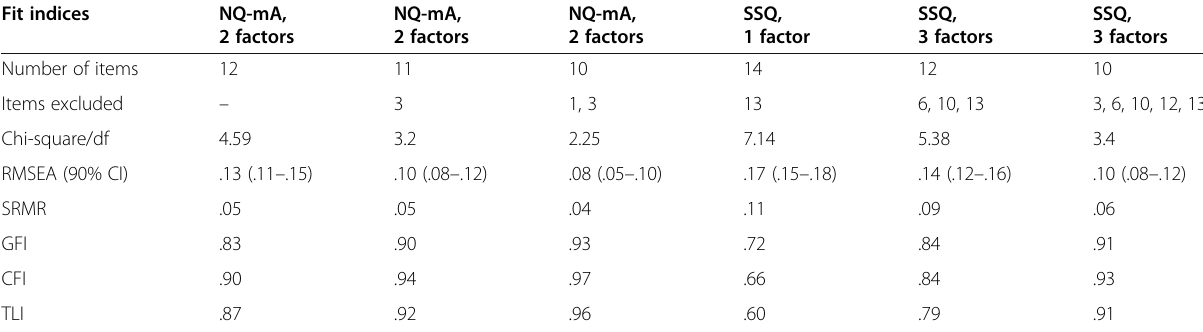
Table 4 Confirmatory factor analysis; Goodness-of-fit indices for Nuss Questionnaire modified for Adults and Single Step